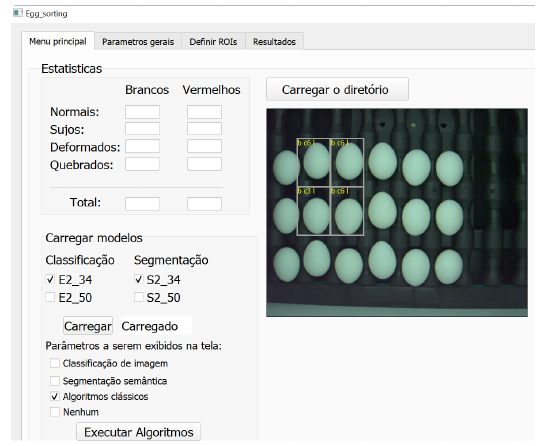
Figure 7. Interface designed in Qt